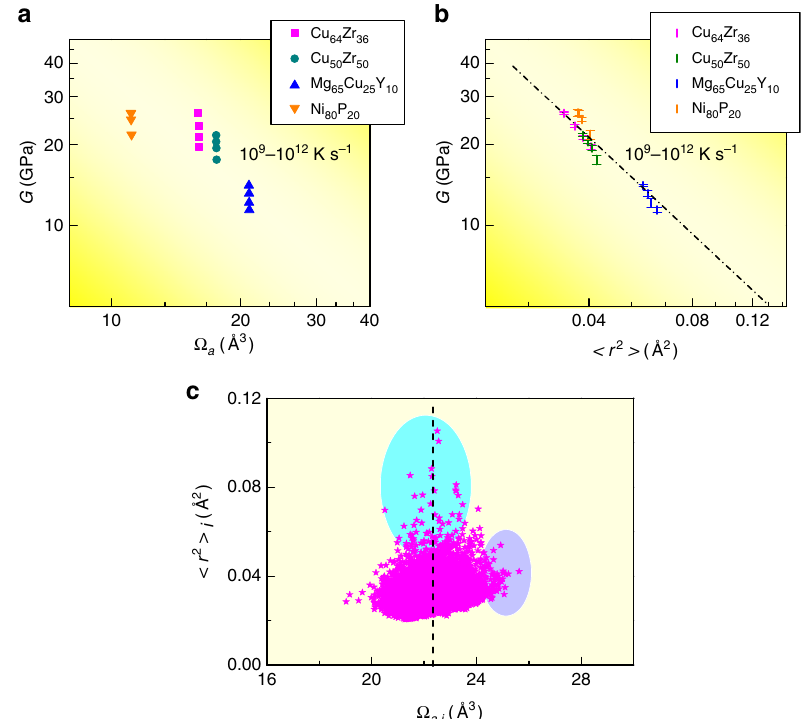
Figure 1 | Vibrational mean square displacement in comparison with atomic volume. Molecular dynamics simulations of four representative MGs, including Cu 64 Zr 36 , Cu 50 Zr 50 , Ni 80 P 20 and Mg 65 Cu 25 Y 10 , prepared using different cooling rates (Samples G1-G16 in Supplementary Table 1). ( a ) The change in shear modulus ( G ) is obvious for different cooling rates, but that in free volume (or O a ) is not easily detectable. ( b ) In contrast, the obvious change in G appears to correlate with an obvious difference in ensemble-averaged vibrational MSD, at room temperature (with denoted error bar of standard deviation). This sensitive dependence reveals the important role of o r 2 4 in reflecting the flexibility of atoms, although vibrational MSD alone does not quantitatively determine G , as discussed below. ( c ) The o r 2 4 i for the i th atom is not simply proportional to its atomic volume (Voronoi volume), O a, i . These two quantities are plotted and compared here, for each of the Zr atom in the Cu 64 Zr 36 MG (Sample G1). The dashed line marks the system- average value of O a